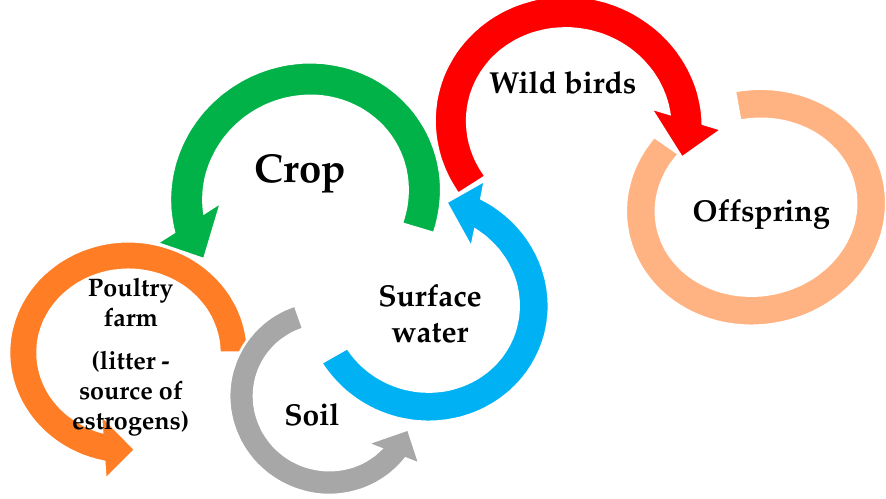
Figure 2. Estrogen contamination route (based on [5,102,103,105,106]).